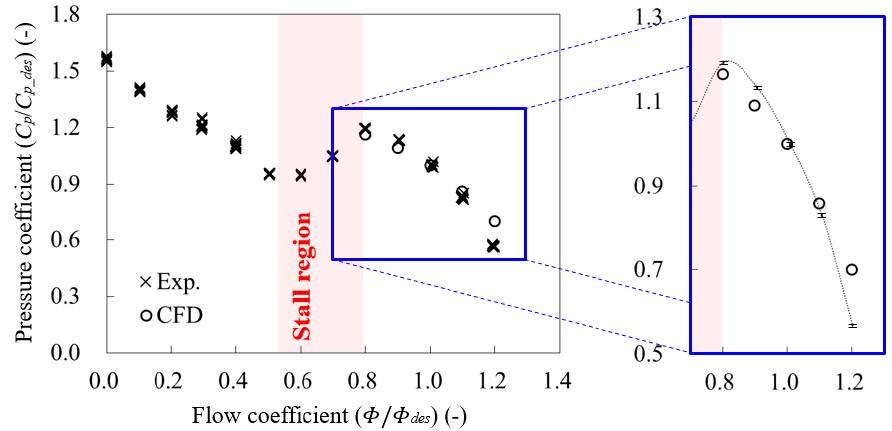
Figure 8. Validation between the numerical and experimental results with expanded uncertainty